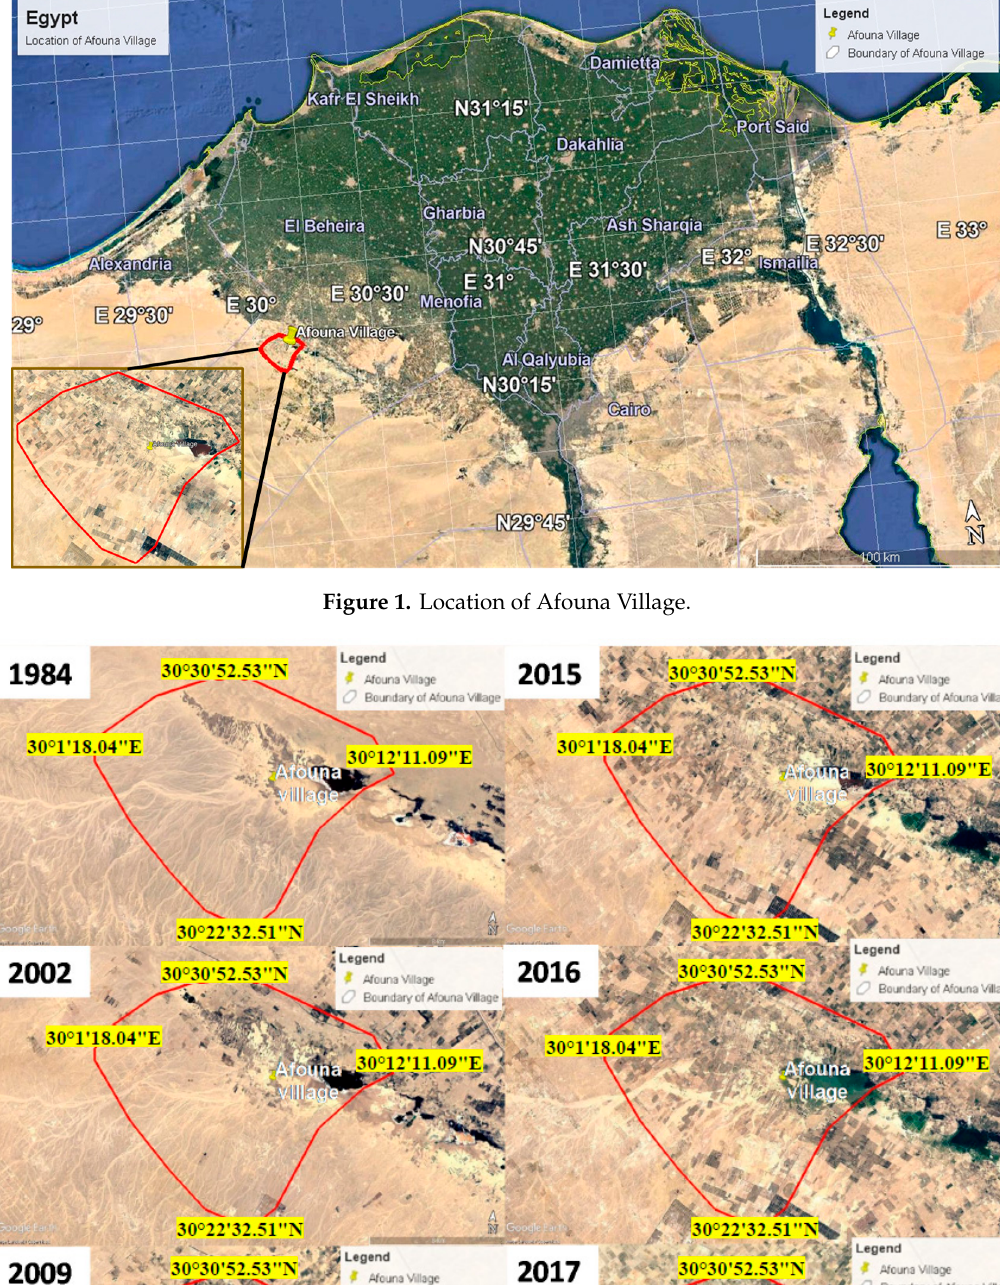
Figure 2. Land-use changes with time and the effect of the flooding.